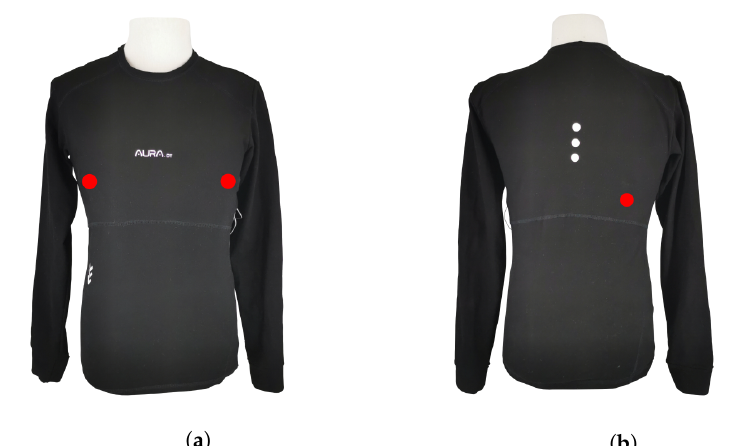
Figure 7. First-layer t-shirt with the location of the electrodes marked in red: ( a ) front view ( b ) rear view.